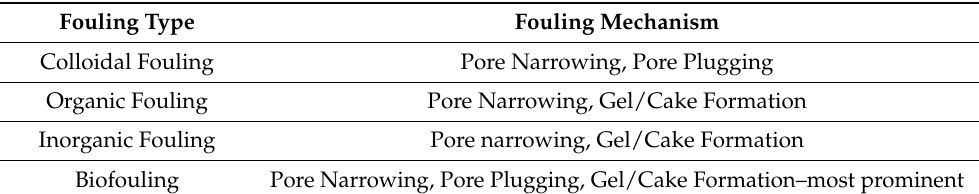
Figure 1. Schematic illustration of colloidal, organic, inorganic, and biofouling. Table 4. Various fouling mechanisms according to fouling types.